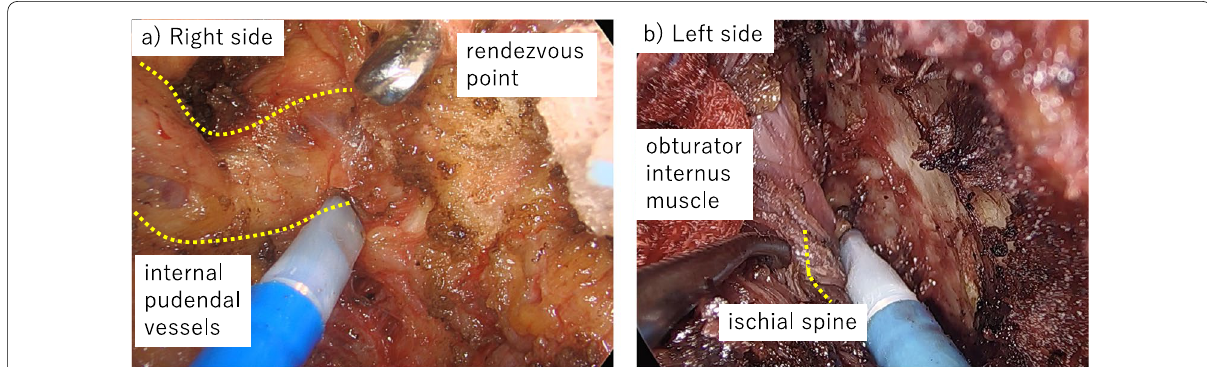
Fig. 2 Transanal total mesorectal excision a The rendezvous point is used to identify the internal pudendal vessels (yellow dashed line) from the perineal side. b The ischial spine (yellow dashed line) was identified, and the obturator internus muscle was dissected, exposing the bone